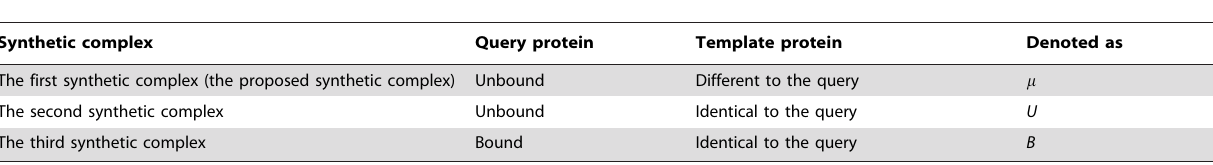
Table 5. The three synthetic complexes employed in the analysis of structural variations.